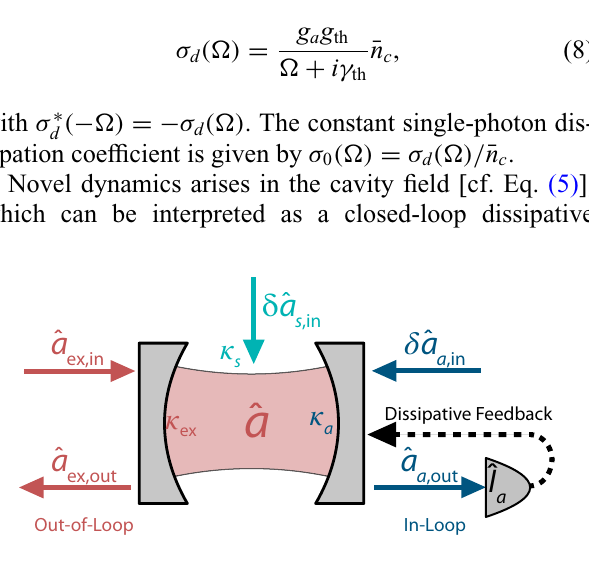
FIG. 1. Scheme for dissipative feedback in an optical micro- cavity. The intracavity field ˆ a is coupled to several different reservoirs, i.e., the laser input ˆ a ex,in , the vacuum noise from the scattering loss δ ˆ a s ,in and the dissipative absorption δ ˆ a a ,in . The in-loop measurement of absorption field ˆ a a ,out , results in the absorption flux ˆ I a , which is fed back to the optical cavity (black dashed curve). The out-of-loop measurement of ˆ a ex,out is performed for coherent and incoherent